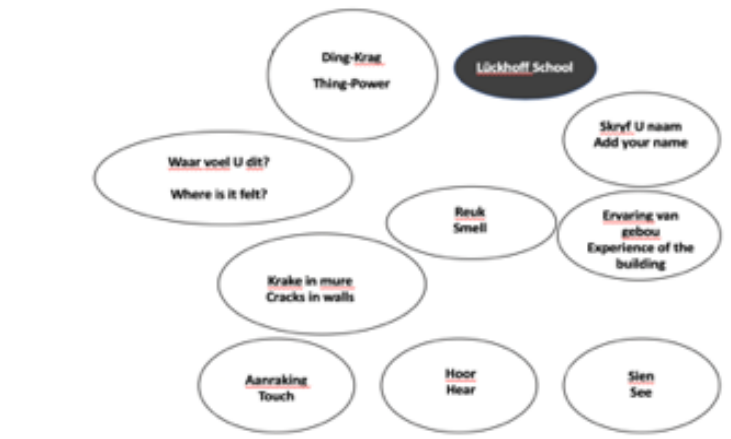
Figure 18 : The Lückhoff School workshop process